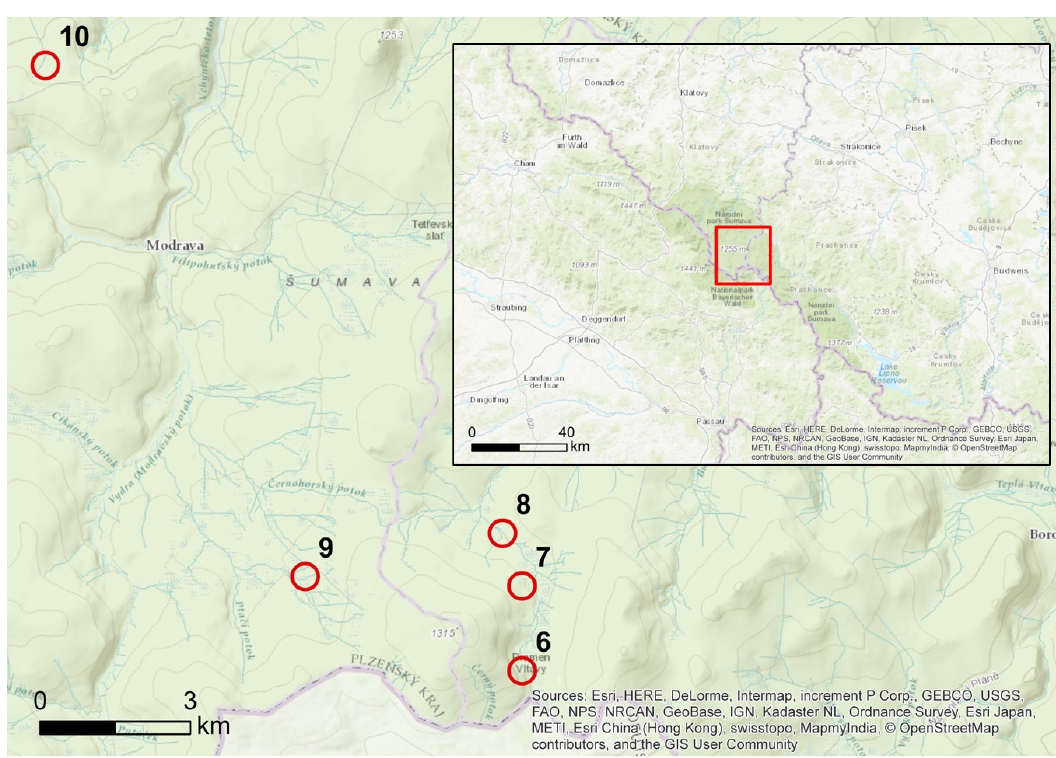
Figure 4. Map of the used localities in the Sumava NP (Source: Own work/ESRI ArcMap Basemap). The number of the points represents the ID numbers.